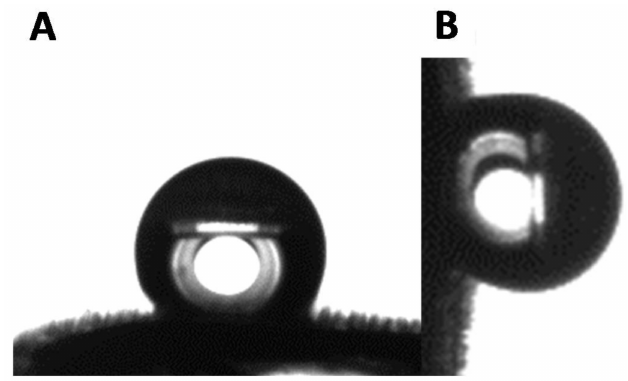
Figure 5. Example of parahydrophobic features observed on the white part of a G. orientalis elytron. Water droplet on ( A ) horizontal and ( B ) tilted surface.